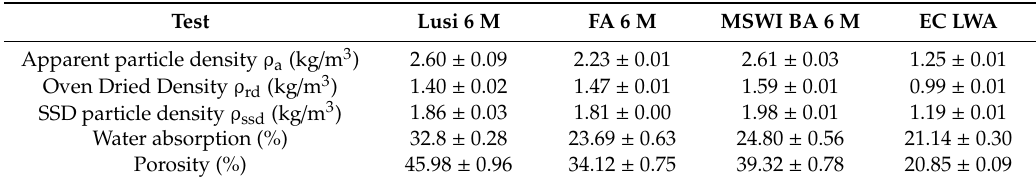
Table 5. Mass density and water absorption of the resulting